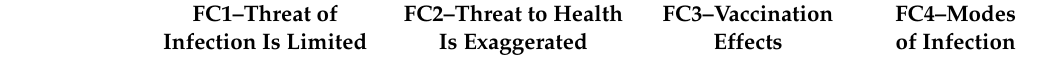
Table 2. Correlation between factors and beliefs about COVID-19 and COVID-19